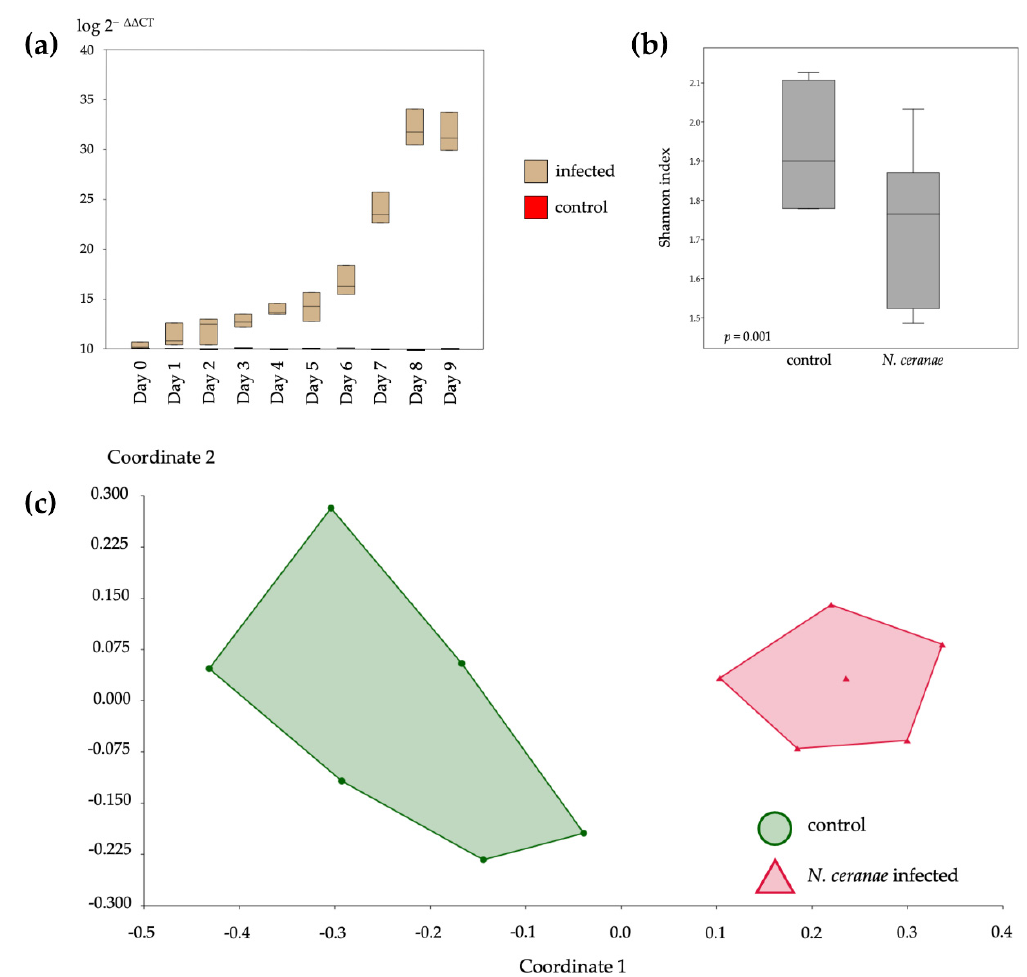
Figure 3. Nonsema ceranae infection level and diversity analysis of bacterial communities in honey bee. The expression level, calculated by 2 −∆∆ CT method, of N. ceranae expression in honeybee from day 0 to 9, showing that the Nosema infection was increased over the period of 8 days and stabilized on day 9 ( a ). Alpha diversity, indexed with the Shannon parameter, of bacterial communities of control and infected bees that were significantly different ( t = 4.3832, p = 0.001) ( b ). The nonmetric multidimensional scaling (NMDS) analysis of bacterial communities between the control and infected groups of honeybees showed that the bacterial communities of Nosema -infected were significantly different from those of the control (F = 10.28, p = 0.002), with a stress value of 0.1131 ( c ).